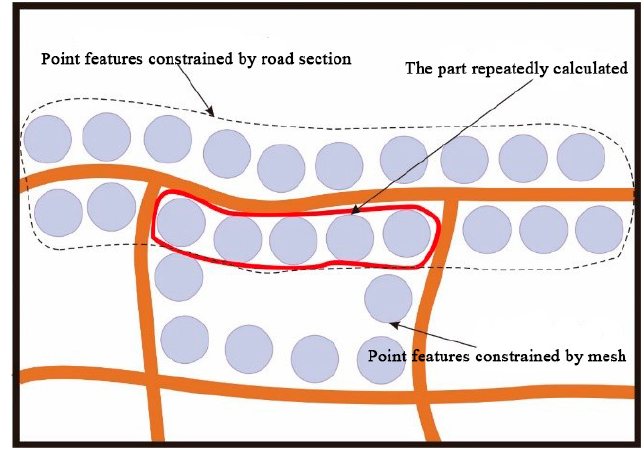
Figure 4. Repeated areas in the process of the point load calculation.